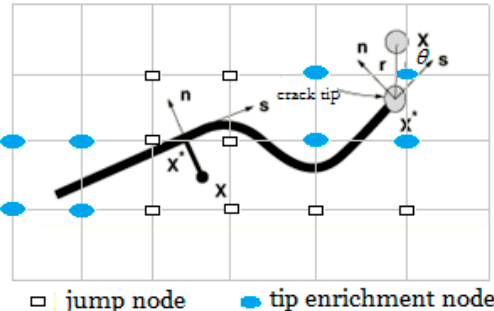
Figure 3. Schematic of a node in cracked enriched elements.